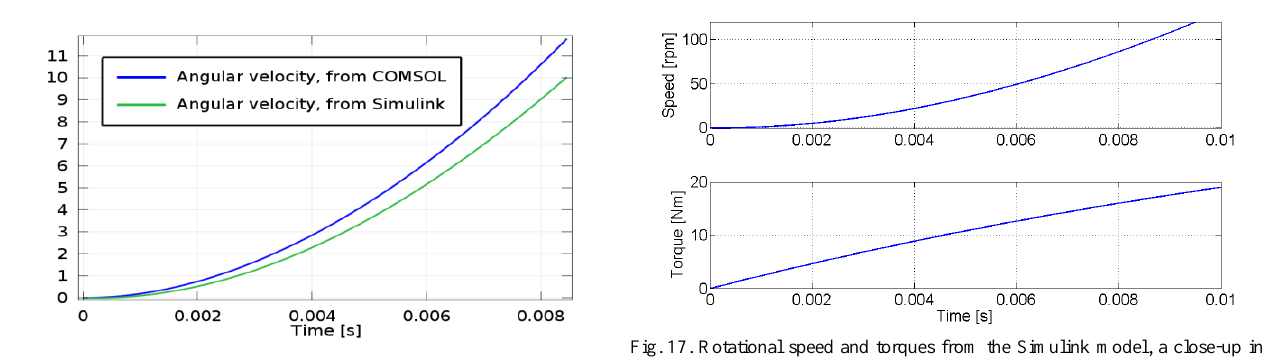
Fig. 15. Comparison of the input (from Simulink) and the speed calculated by COMSOL using inertia and torque.